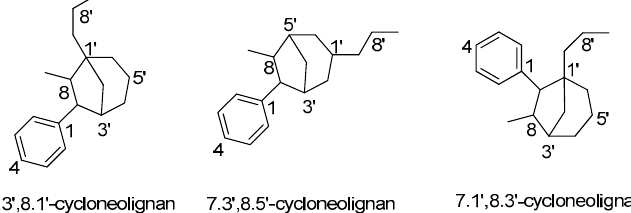
Figure 11. Subtypes of cycloneolignans.